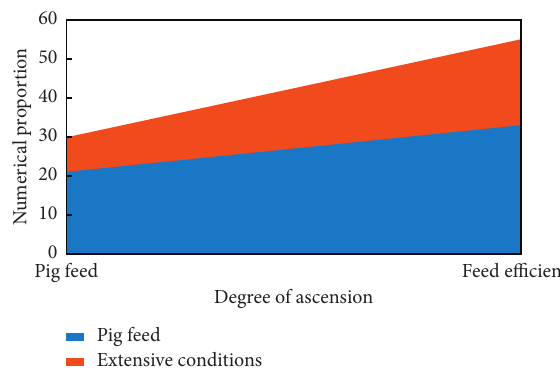
Figure 2: Application experimental data of BFA on fat pigs.